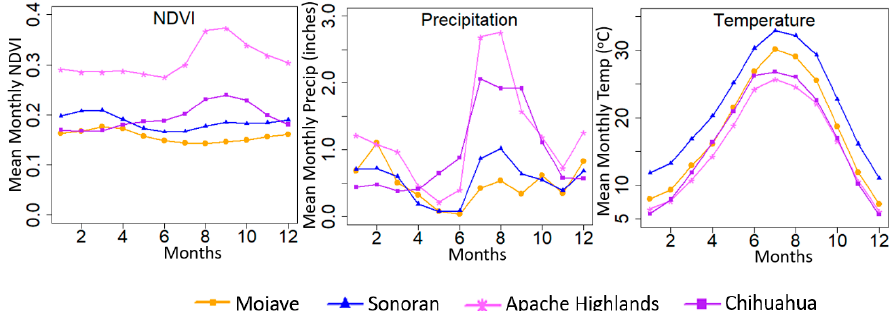
Figure 2. The spatiotemporal monthly mean graph of vegetation productivity (Normalized Difference Vegetation Index: NDVI) and climatic variables such as precipitation and temperature for four ecoregions from 2000 to 2015 where months are shown in numeric order starting with January [24,28,29].